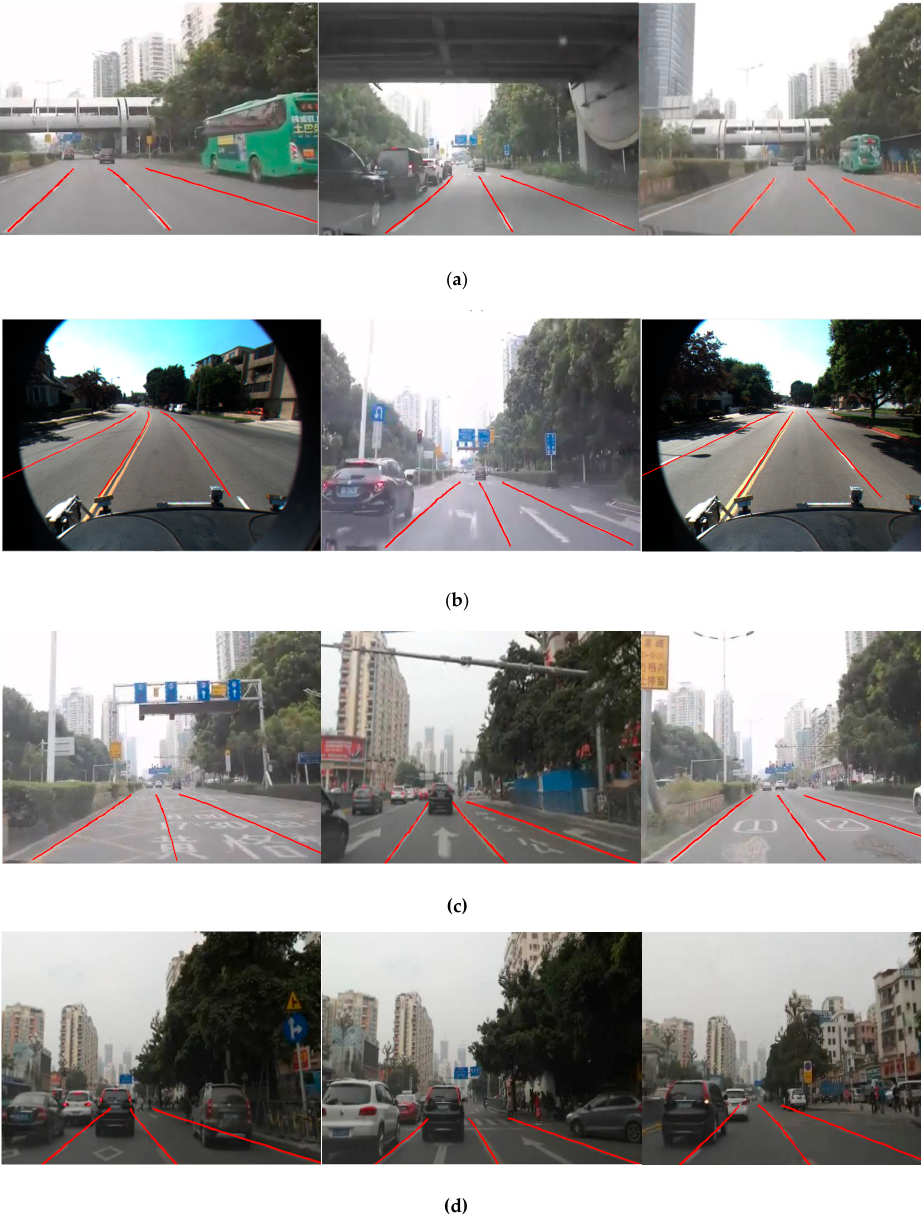
Figure 13. The proposed method detects the lane in four different types of scenarios. ( a ) Scenario 1 with normal illumination and good pavement. ( b ) Scenario 2 with intense illumination and shadow interruption. ( c ) Scenario 3 with normal illumination and sign-on-the-ground interruption, and ( d ) scenario 4 with poor illumination and vehicle interference.